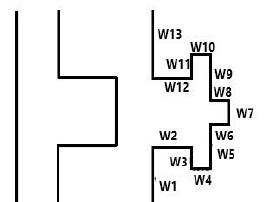
Figure 3: Geometrical details of modified Hilbert